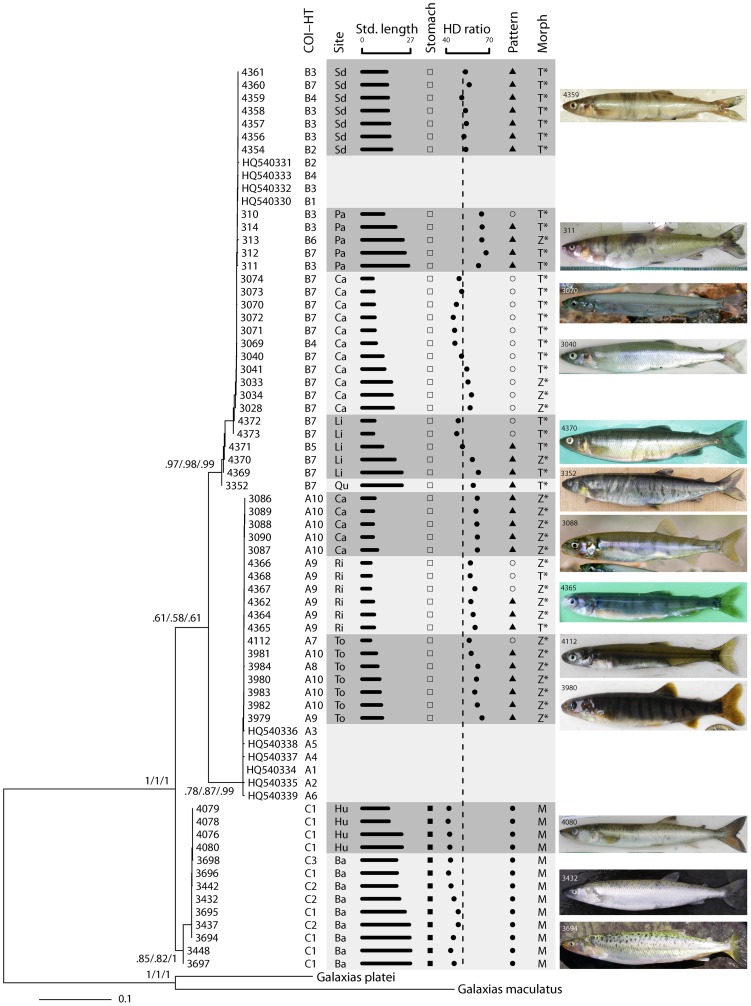
Maximum likelihood tree and three traditional diagnostic morphological characters for Aplochiton.Each leaf of the tree is labeled with individual ID-code (this study; n = 60 sequences), haplotype accession number, or outgroup species name (refer to Table 4). Branch support is indicated nearby nodes for inferences based on maximum likelihood (ML, bootstrap), Bayesian Inference (BI, posterior probability), and parsimony (P, bootstrap) (i.e. ML/BI/P); values <0.50 not shown. Cytochrome Oxidase I haplotype (COI-HT) correspond to those in Vanhaecke et al.
[7] when matching, or to the new haplotypes described here. The first letters of COI-HT stand for haplogroups that were associated with species: A (associated with AZ), B (AT), and C (AM). Additional data are shown with an alternating shaded background to aid the visual separation of each sampling site listed as ''Site'' on the second column (unavailable for sequences downloaded from Genbank). Std. Length is standard length in cm. Stomach displays either the bulbous (□) or elongated (▪) shape. HD ratio is head length to head depth ratio (%), with head depth measured posterior to eye orbit (dashed line corresponds to that in Figure 3-A, for reference). Pattern refers to skin color patterns; dark chevron blotches (▴), dark spots (•) and unclear/no pattern (○). Morph corresponds to morphological identification; letters are initials of the second word (species) in binomial names. Morphological identification was accomplished by reference to Stomach and Pattern (M), or by jackknife identification using linear discriminant analysis based on all five characters analyzed (T and Z; method indicated by *). Note several discrepancies between morphological and barcoding identifications. Some fish photos further illustrate Aplochiton phenotypic diversity (IDs correspond tree leaf labels).